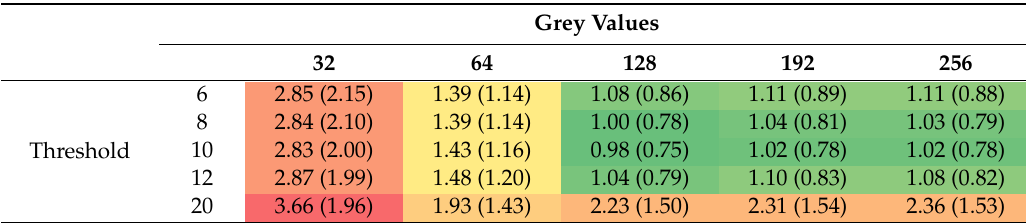
Table 7. Decision support for the identification of the most valuable detector threshold and grey value combination with a priority on the amount of correctly identified stones. Values represent the results for a bu ff er size of 1.50 m (3.00 m in parentheses) between the manually and automatically classified stones. Values close to 0.10 are more similar to the manual method. Color scale indicates good values in green and bad values in